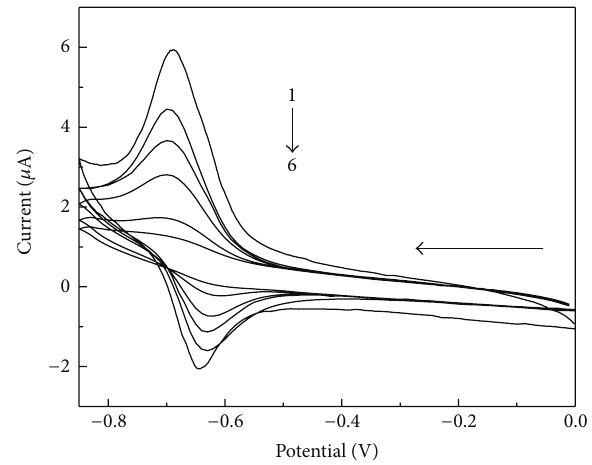
Figure 4: Cyclic voltammogram of doxorubicin hydrochloride in the absence (1) and presence of different CT DNA concentrations: 19.9 𝜇 M (2), 59.31 𝜇 M (3), 98.2 𝜇 M (4) 174.47 𝜇 M (5), and 230.85 𝜇 M (6). Scan rate = 0.100 Vs −1 , pH = 7.4, [ NaCl ] = 0.160 M, and temperature = 25 ∘